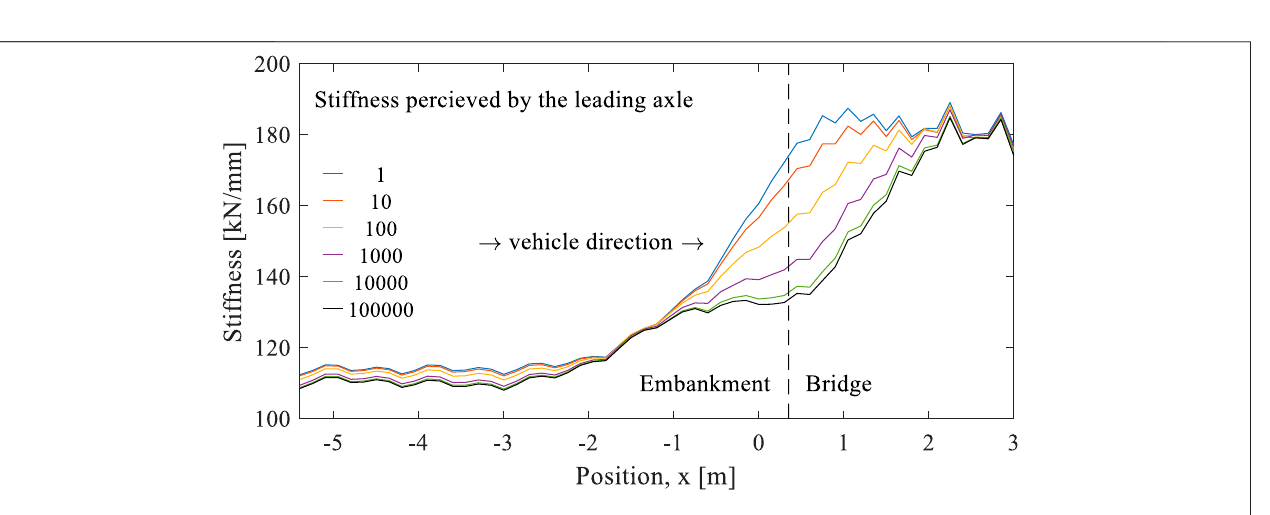
Frontiers in Built Environment |